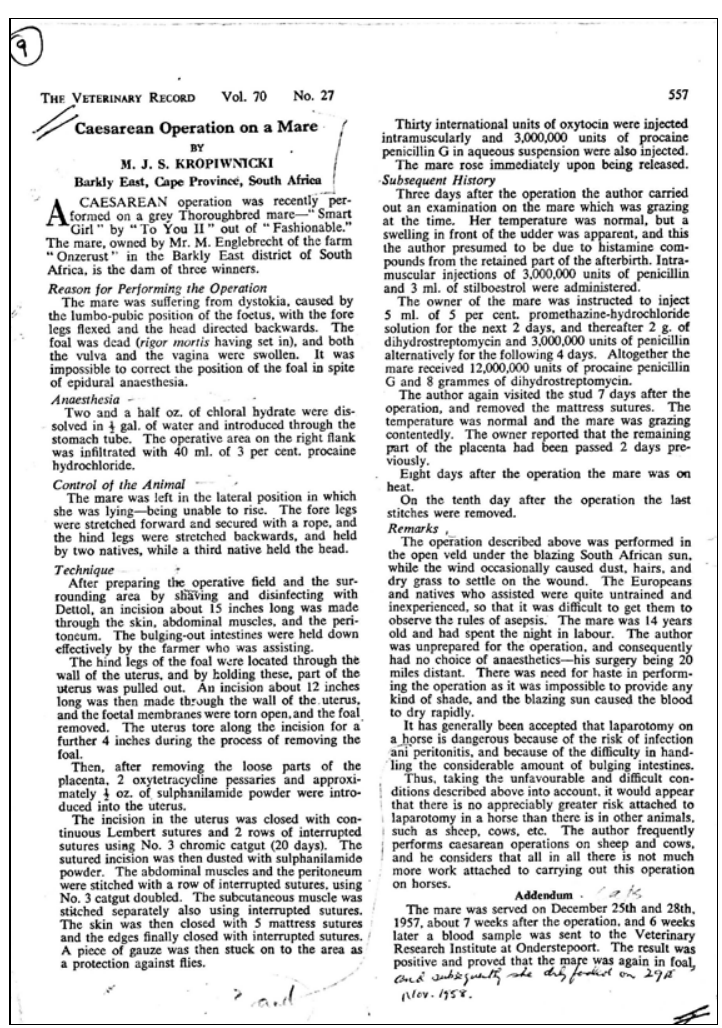
Figure 1: Caesarean operation on a